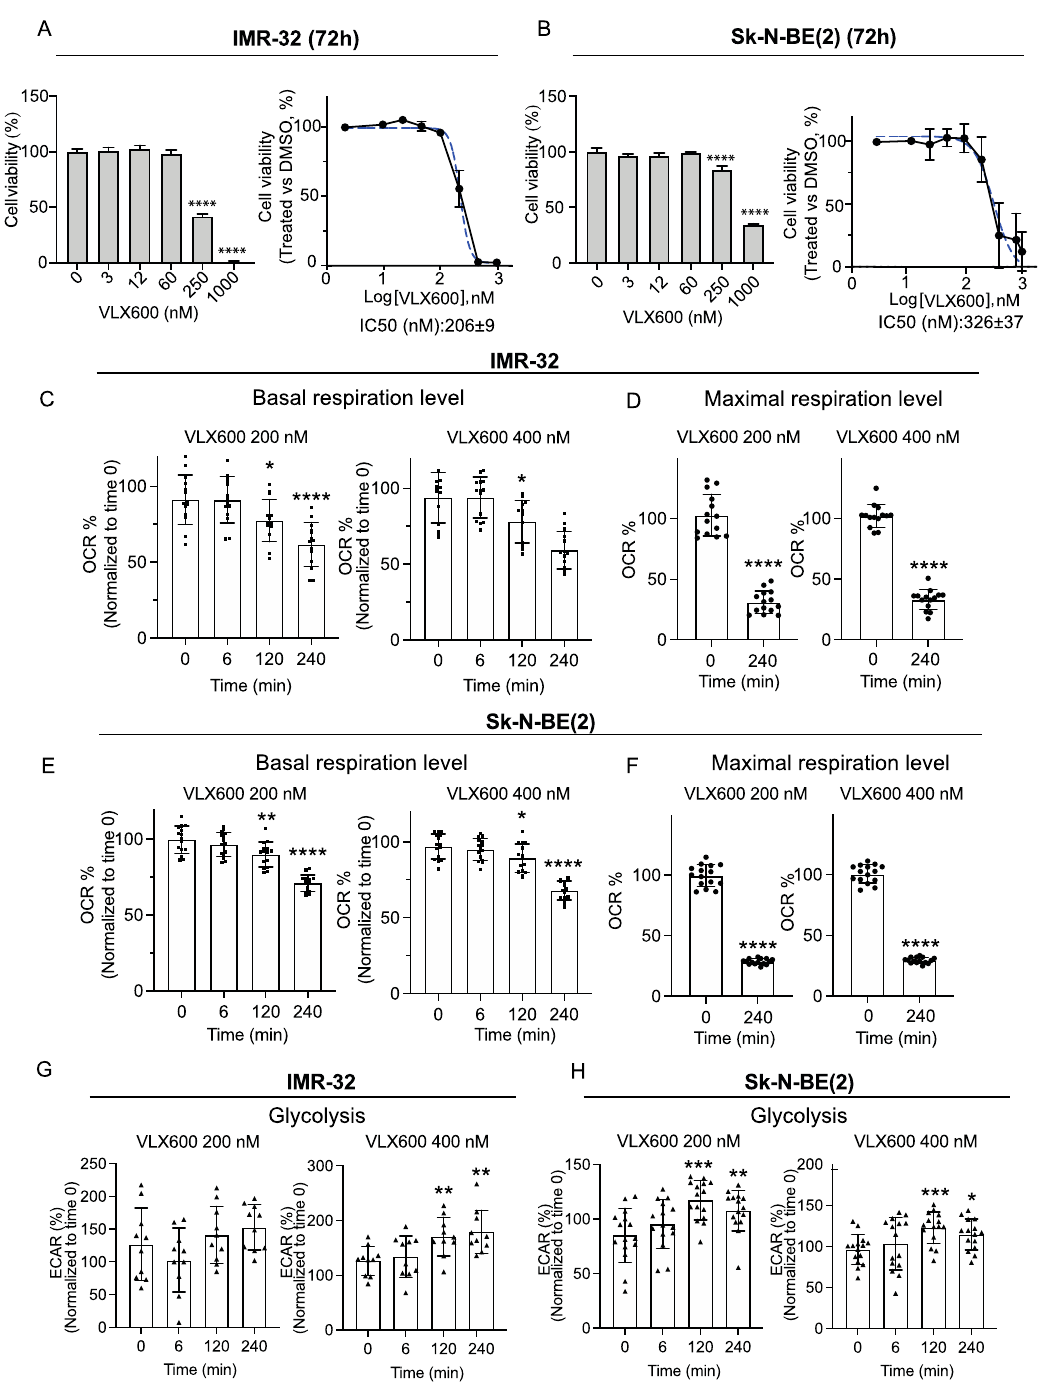
Figure 2. Iron chelator VLX600 inhibited mitochondrial respiration and induced efficient cell death in MYCN-amplified neuroblastoma cells. ( A , B ) Dose-dependent sensitivity of MYCN -amplified IMR-32 and Sk-N-BE(2) neuroblastoma cells to VLX600. Left : bar chart, dose response from an in- dividual experiment. Right : dose-response curve from three individual experiments. IC 50 206 ± 9 nM in IMR-32 cells and IC 50 326 ± 37 nM in Sk-N-BE(2). ( C ) Basal respiration level in IMR-32 cells treated with 200 nM or 400 nM VLX600. Oxygen Consumption Rate (OCR) was measured at indi- cated time points after VLX600 injection (6, 120 and 240 min). Final data are presented as percentage (%, normalized to values at time 0). ( D ) Maximal respiration level in IMR-32 cells treated with 200 nM or 400 nM VLX600 for 4 h. Oxygen Consumption Rate (OCR) was measured after FCCP injec- tion. Final data are presented as percentage (%, normalized to values at time 0). ( E ) Basal respiration level in Sk-N-BE(2) cells treated with 200 nM or 400 nM VLX600. Oxygen Consumption Rate (OCR) was measured at indicated time points after VLX600 injection (6, 120 and 240 min). ( F ) Maximal respiration level in Sk-N-BE(2) cells treated with 200 nM or 400 nM VLX600 for 4 h. Oxygen